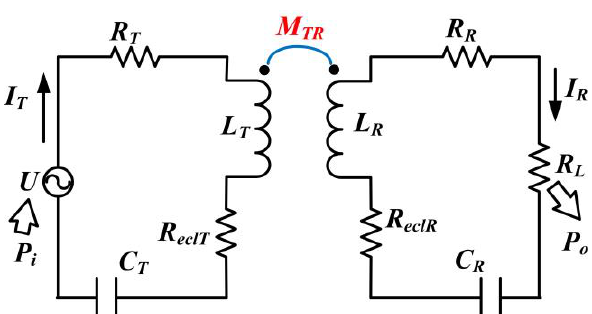
Figure 3. J. Mar. Sci. Eng. 2019 , 7 , 267